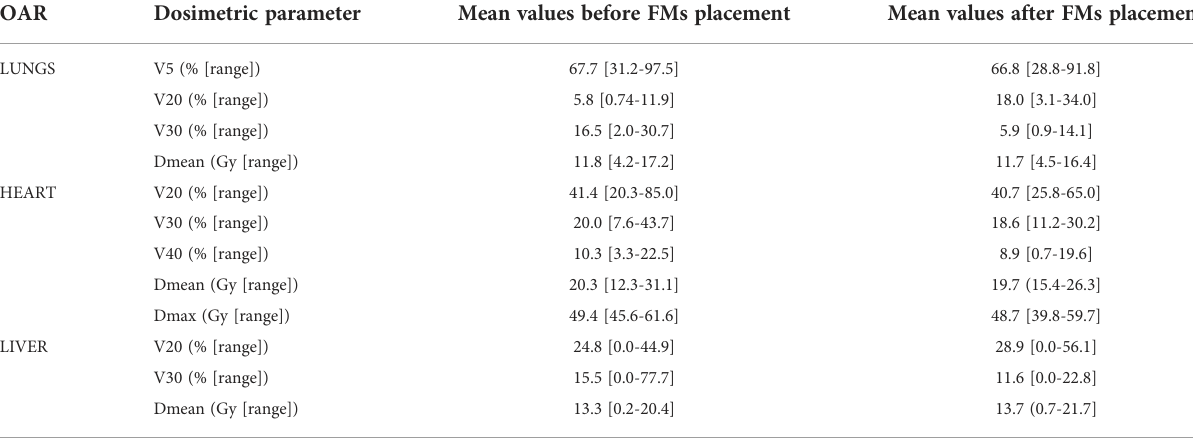
Mean values and range are reported.